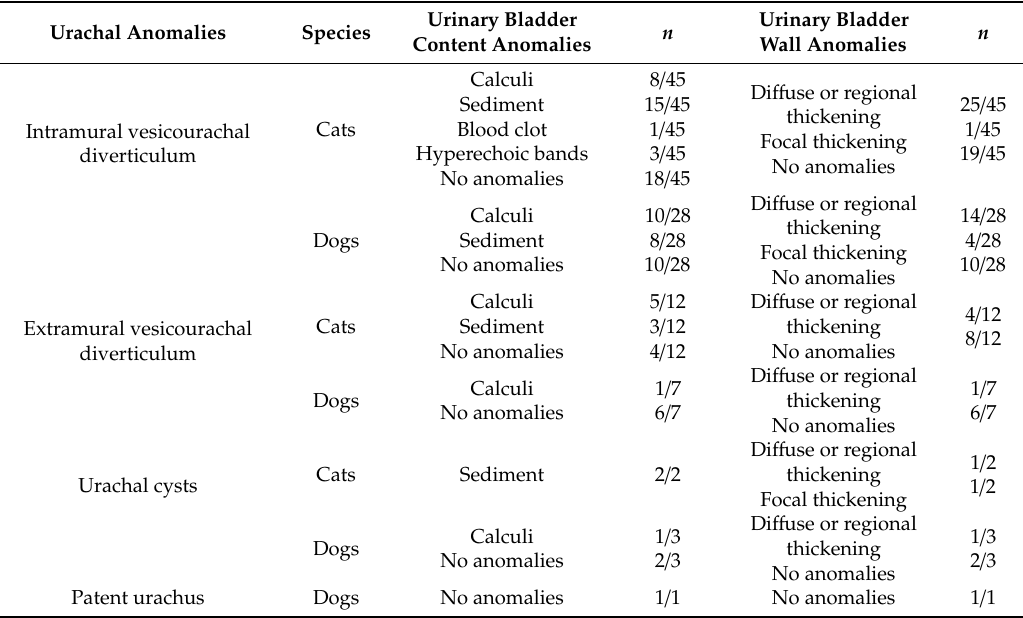
Table 2. Prevalence of urinary bladder content and wall anomalies in all patients included with di ff erent type of urachal